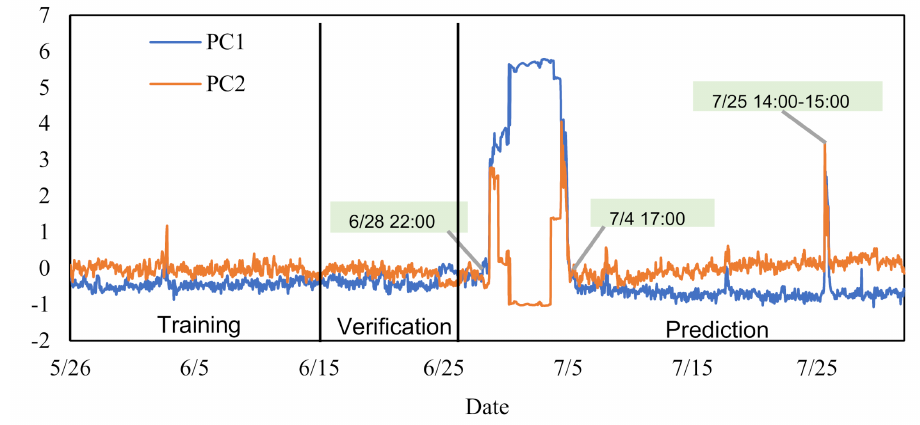
Figure 7. The signal